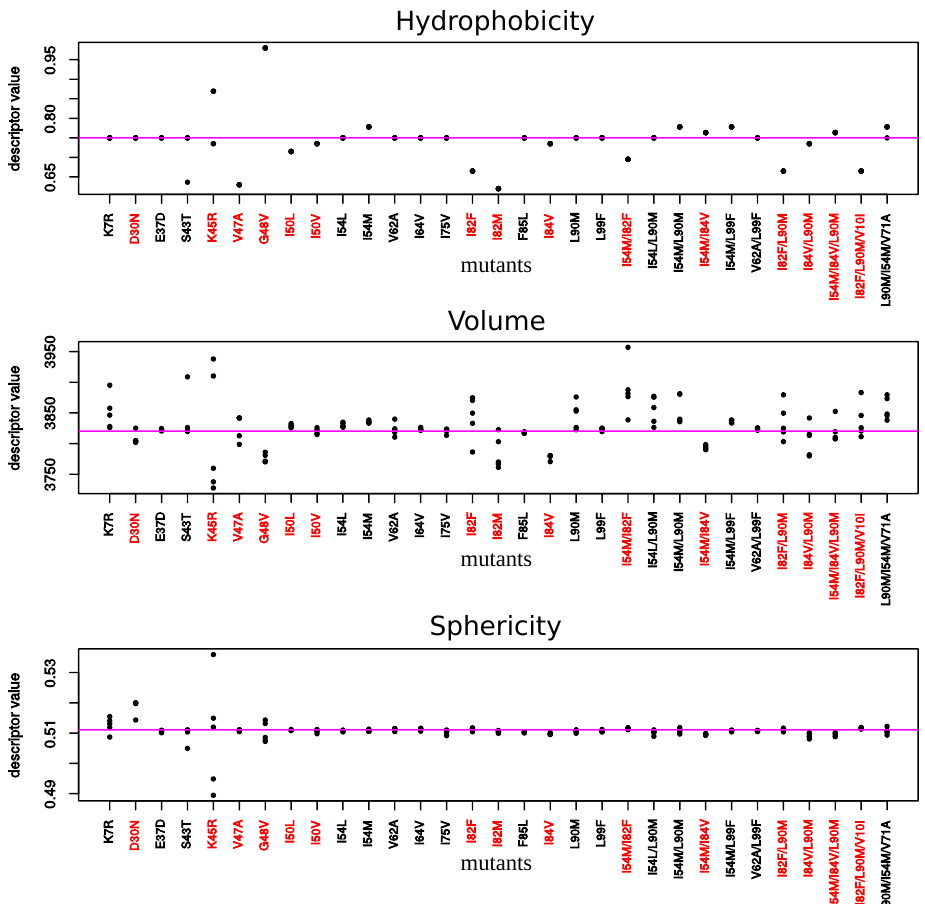
Figure 6. Hydrophobicity, volume, and sphericity of pockets extracted from each mutant structure. Red mutants correspond to mutants exhibiting at least one mutation in the binding. Each point corresponds to a mutant structure. For some mutants, less than five points appear meaning that several mutant structures exhibit same values for a given